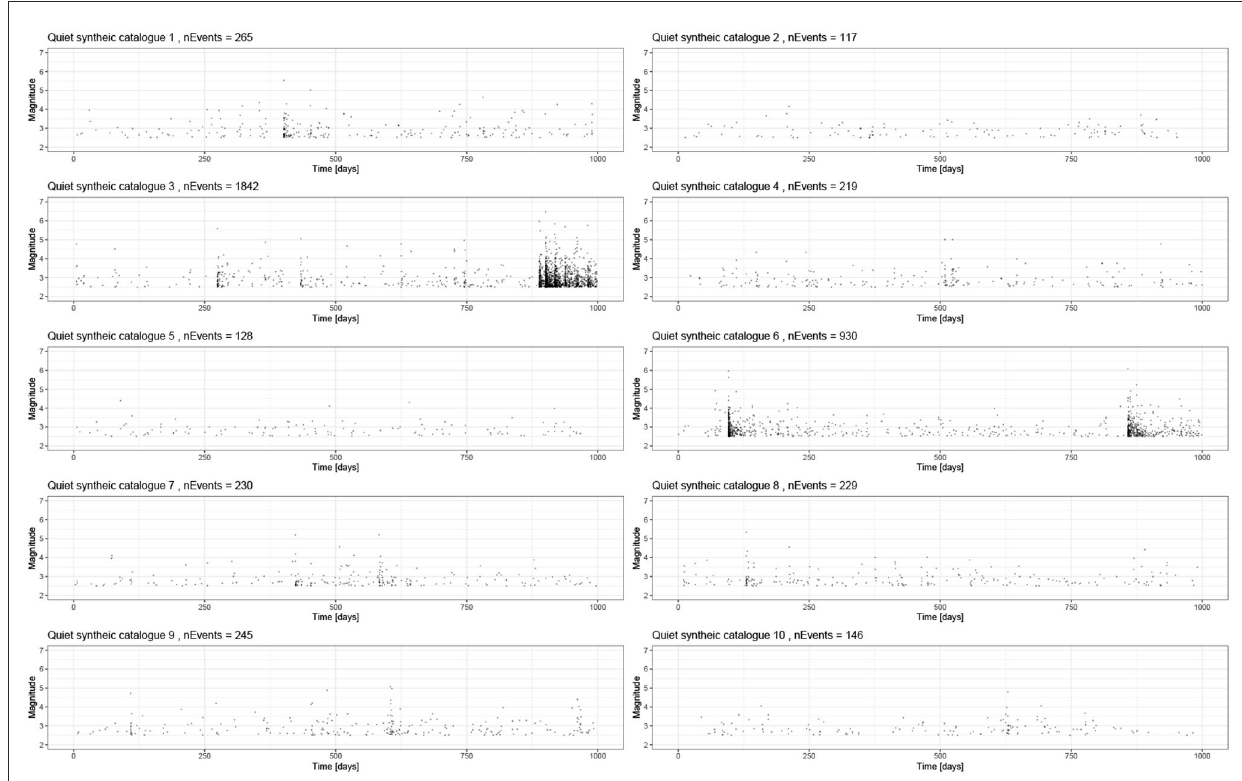
FIGURE6 A total of 10 synthetic catalogs based on the baseline model of 1,000-days with background events but no large seeded event. All parameters are the same between the runs, and these just capture the stochastic uncertainty. These are all inverted using inlabru , and the family of posteriors is presented in Figure